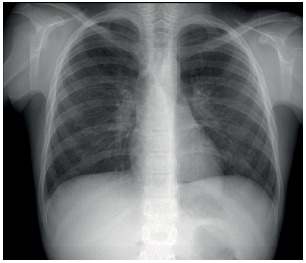
Radiografia de tórax revelando infiltrado peri-hilar e basal de padrão
reticulonodular bilateralmente.